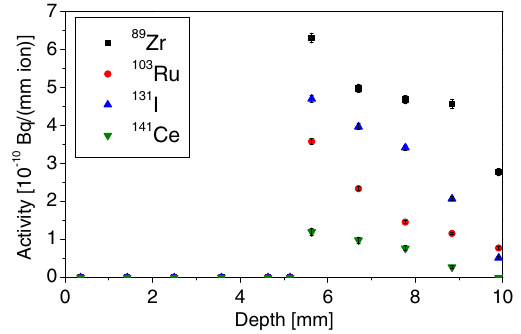
FIG. 6. Depth profiles of selected fragments of 238 U beam with the initial energy 500 MeV = u in copper